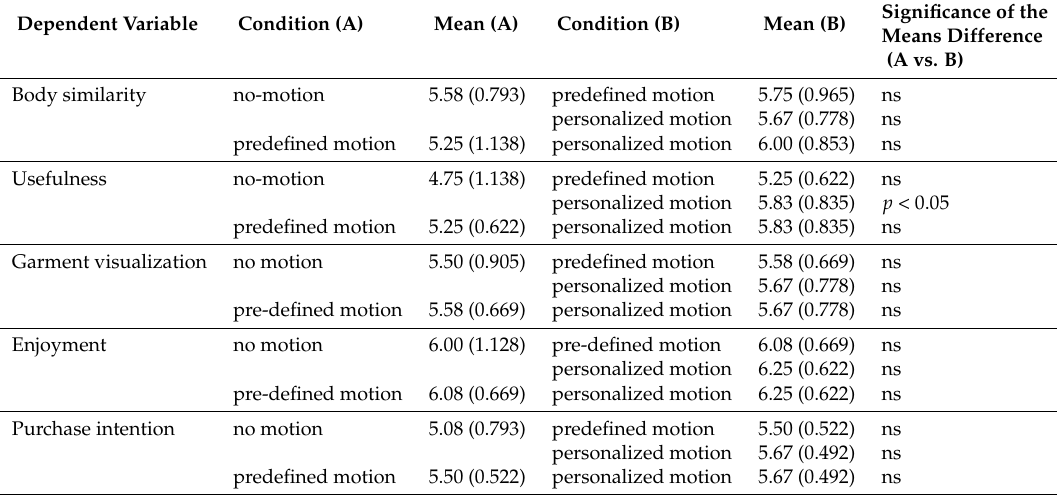
Table 6. Post hoc between-group results.